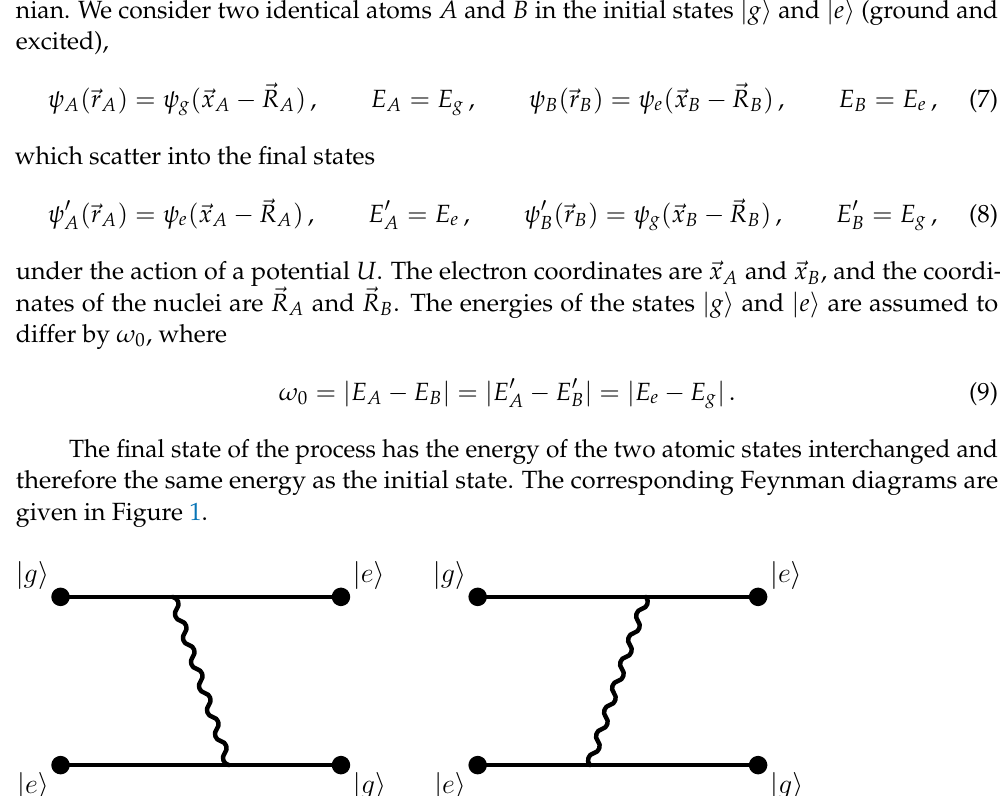
g e , the excited state as | (cid:105) | (cid:105)